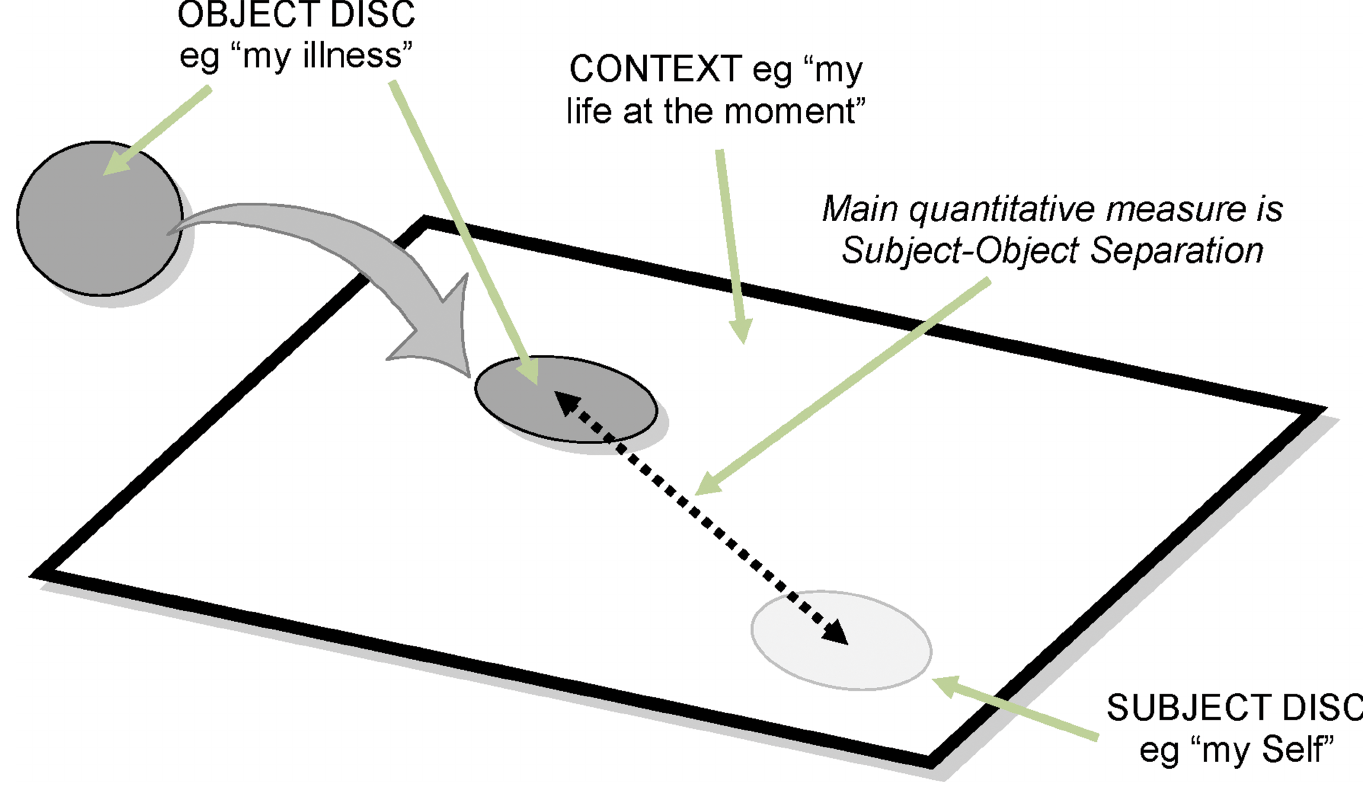
Fig 2. The PRISM